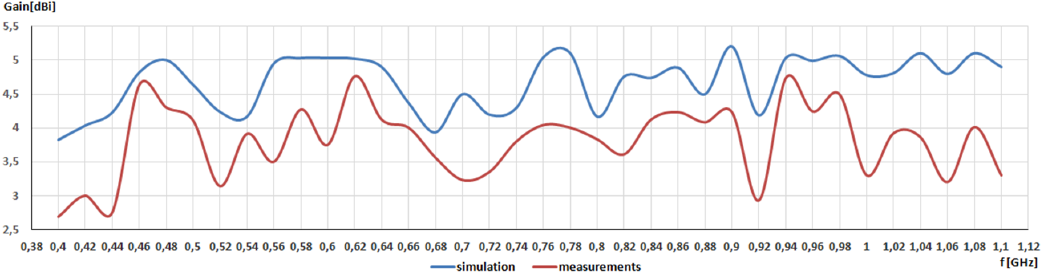
Figure 8. Simulated and measured gain for frequency range from 400 MHz to 1100 MHz.